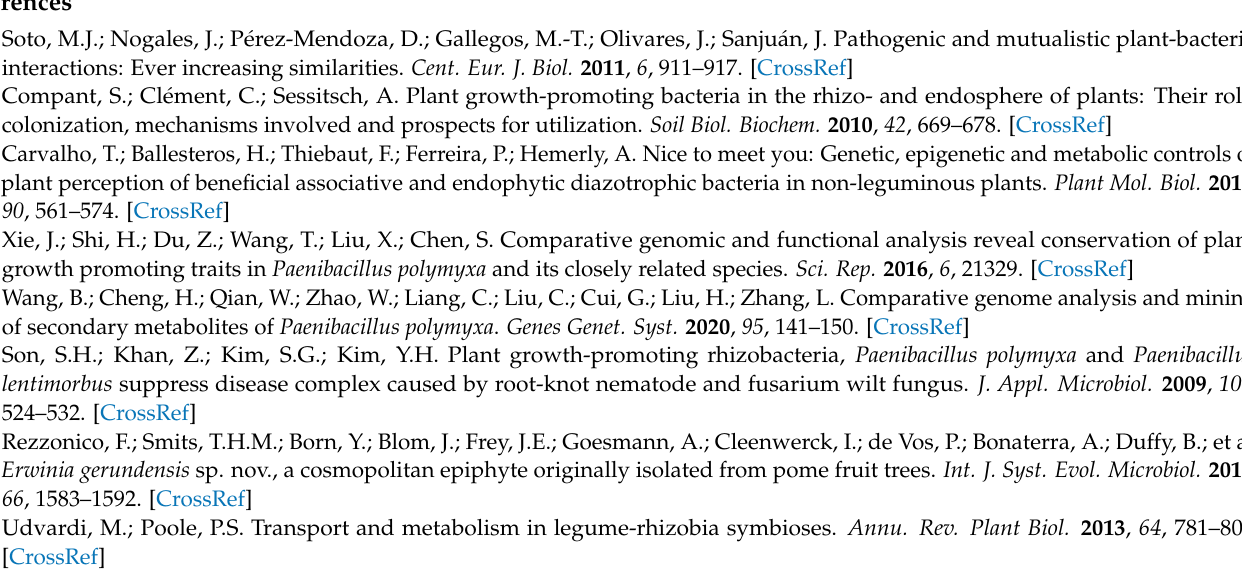
Table S10. Differentially expressed core biosynthetic genes of secondary metabolite gene clusters of strain AR when barley seedlings were present. Table S11. Differentially expressed transcripts encoding disease resistance proteins and heat shock proteins in barley seedlings when the three bacterial strains were present. Table S12. Differentially expressed transcripts associated with defence and stress responses in barley seedlings when the three bacterial strains were present. Table S13. Differentially expressed transcripts encoding endoglucanase in barley seedlings when the three bacterial strains were present. Table S14. Differentially expressed transcripts associated with signal transduction and ethylene biosynthesis in barley seedlings when the three bacterial strains were present. Table S15. Differentially expressed transcripts encoding high-affinity transporters in barley seedlings when the three bacterial strains were present. Table S16. Differentially expressed transcripts associated with nutrient uptake and metabolism in barley seedlings when the three bacterial strains were present. Table S17. Transcript quantification (raw reads count) results for bacterial samples used in the plant–bacteria interaction assay. Table S18. Transcript quantification (raw reads